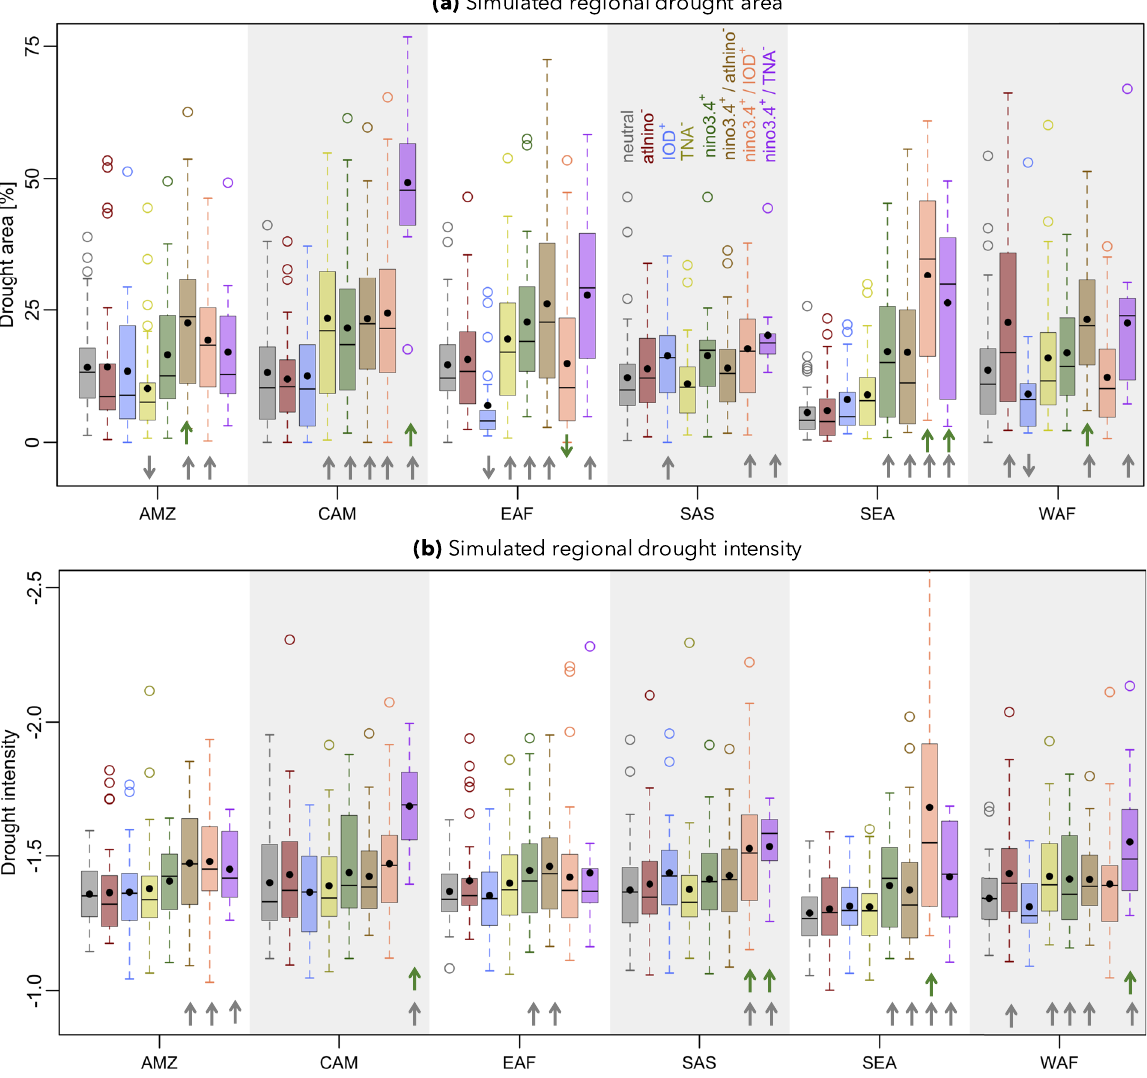
Fig. 5 In fl uence of individual and co-occurring modes of variability on regional drought characteristics. Box plots represent the distribution of a drought area and b drought intensity across a subset of SREX regions with the largest effects of natural variability modes during seasons with neutral conditions, individual occurrences of natural variability modes (AtlNiño, TNA − , IOD + , and Niño3.4 + ), and co- occurring conditions (Niño3.4 + /IOD + , Niño3.4 + /AtlNiño-, and Niño3.4 + /TNA), noted above each boxplot, from the CESM preindustrial simulation. Here, we show a subset of six SREX regions which are signi fi cantly affected by these modes of natural variability. Gray arrows indicate signi fi cant differences in the mean of distribution of drought area and intensity corresponding to various conditions relative to neutral conditions at 5% signi fi cance level. Green arrows indicate signi fi cant differences in the mean of distributions between co-occurring and Niño3.4 + conditions at 5% signi fi cance level. Black dots show the mean of the distribution in each occurring Niño3.4 + /TNA − signi fi cantly (at 5% signi fi cance level) increase drought area over SEA and CAM while Niño3.4 + /IOD + co- occurrence signi fi cantly decreases drought area over EAF and increases drought area over SEA, relative to Niño3.4 + alone (indicated by green arrows in Fig. 5a). AMZ, which experiences no signi fi cant change in drought area under Niño3.4 + relative to neutral conditions, has a signi fi cantly higher drought area when Niño3.4 + /AtlNiño − or Niño3.4 + /IOD + co-occur. Similarly, WAF only shows signi fi cantly higher drought area during co-occurring Niño3.4 + /TNA − and Niño3.4 + /AtlNiño − but not during Niño3.4 + alone. Unlike the in fl uence on drought area, we fi nd a more limited in fl uence of the individual occurrences of these modes on drought intensity over most regions, except an increase in drought intensity over WAF during TNA − and AtlNiño − and over